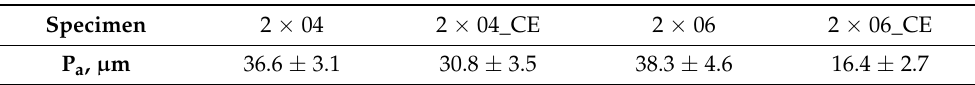
Table 1. Averaged roughness parameter P a for as-build and CE